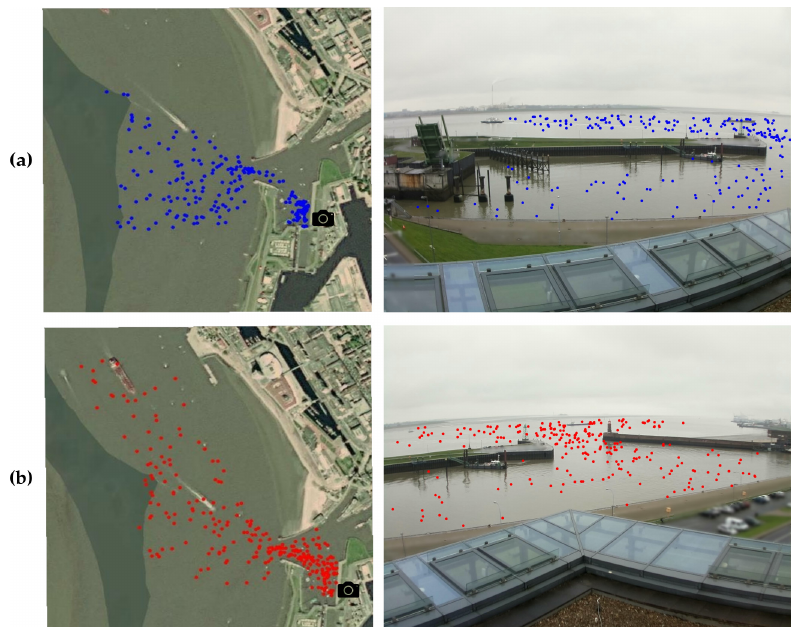
Figure 4. Reference pairs to create the homographies. The coloured dots to the left show the latitudes and longitudes obtained from the AIS messages on a map. To the right, the counterpart pixel coordinates are displayed, annotated by hand. The black icons show the location of the cameras. ( a ) First camera pairs for homography creation, with blue dots. ( b ) Second camera pairs for homography creation, with red dots.